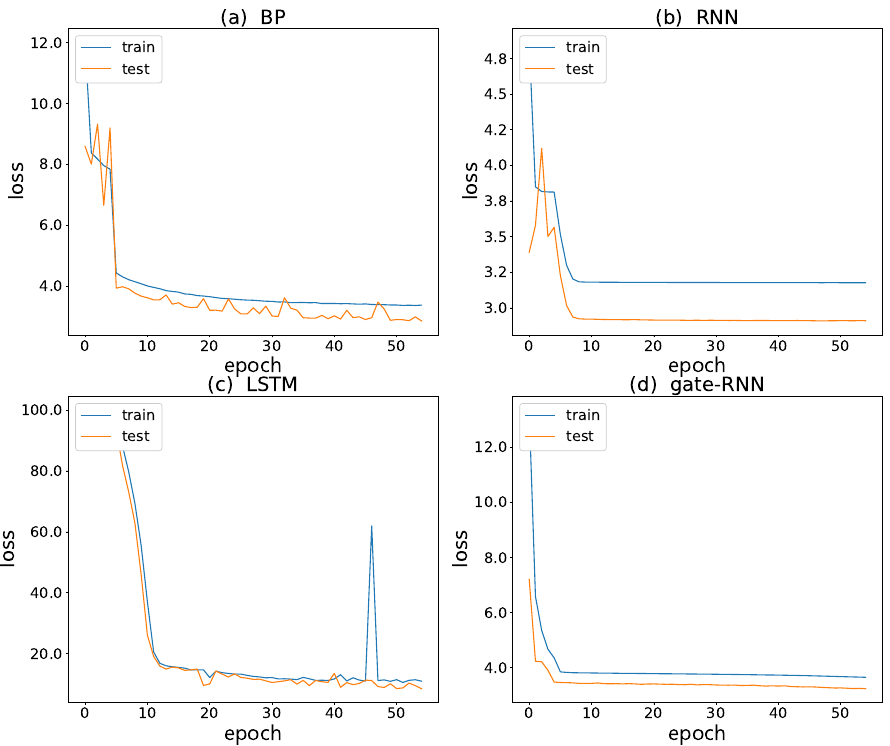
Figure 15. Neural networks’ losses on the train and test datasets for 40-min time scales: ( a ) loss of BPNN; ( b ) loss of RNN; ( c ) loss of LSTM; and ( d ) loss of gate-RNN. The blue line is the train loss curve and the orange line is the test loss curve.